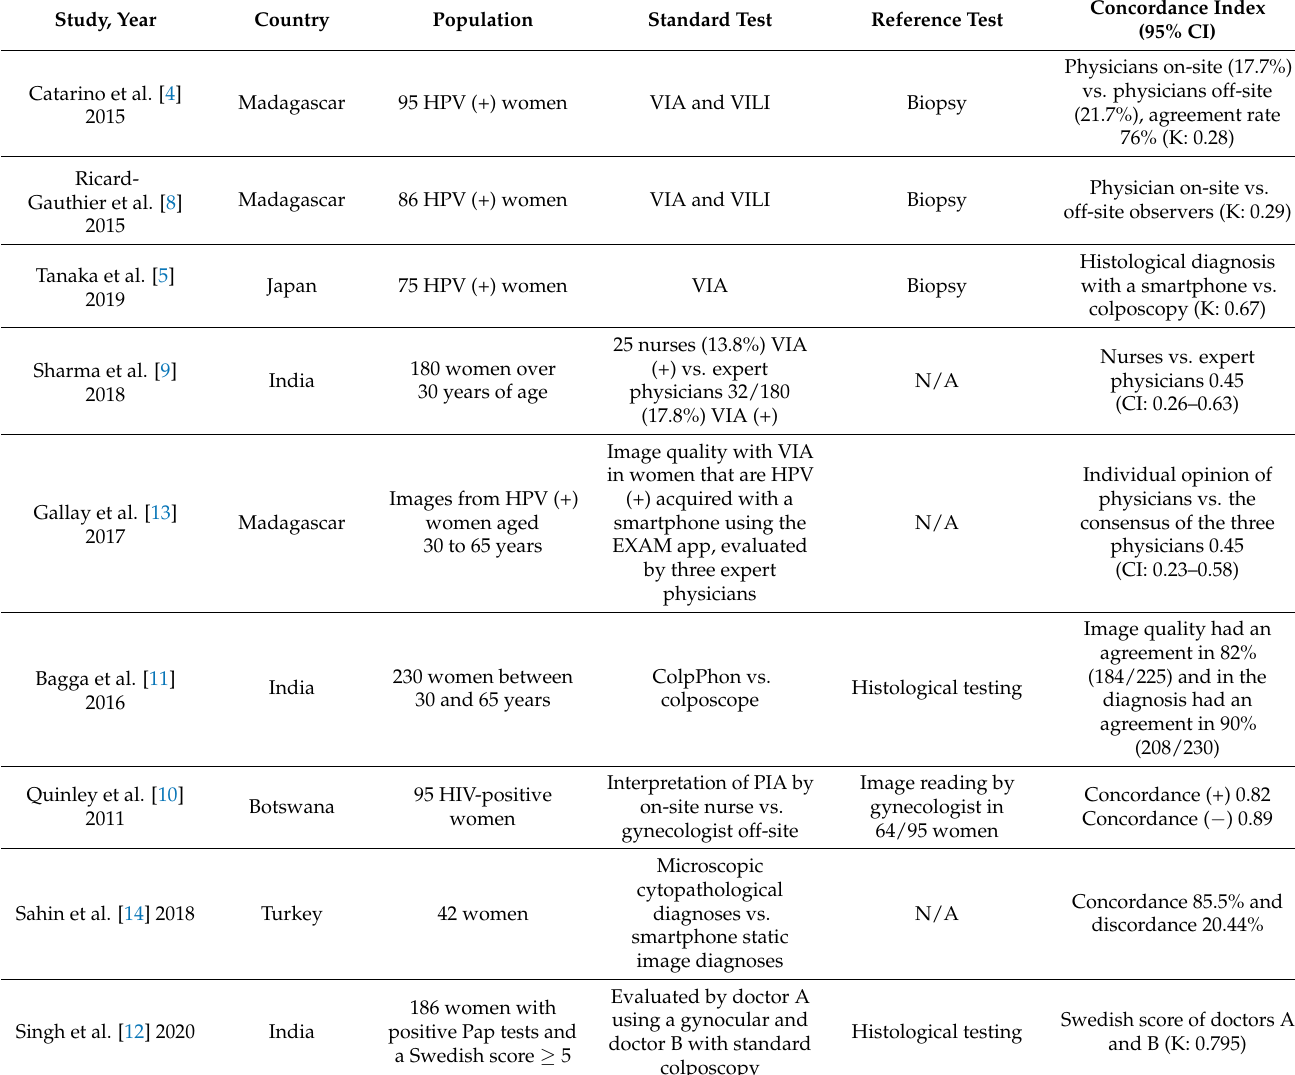
Table 2. Concordance analysis